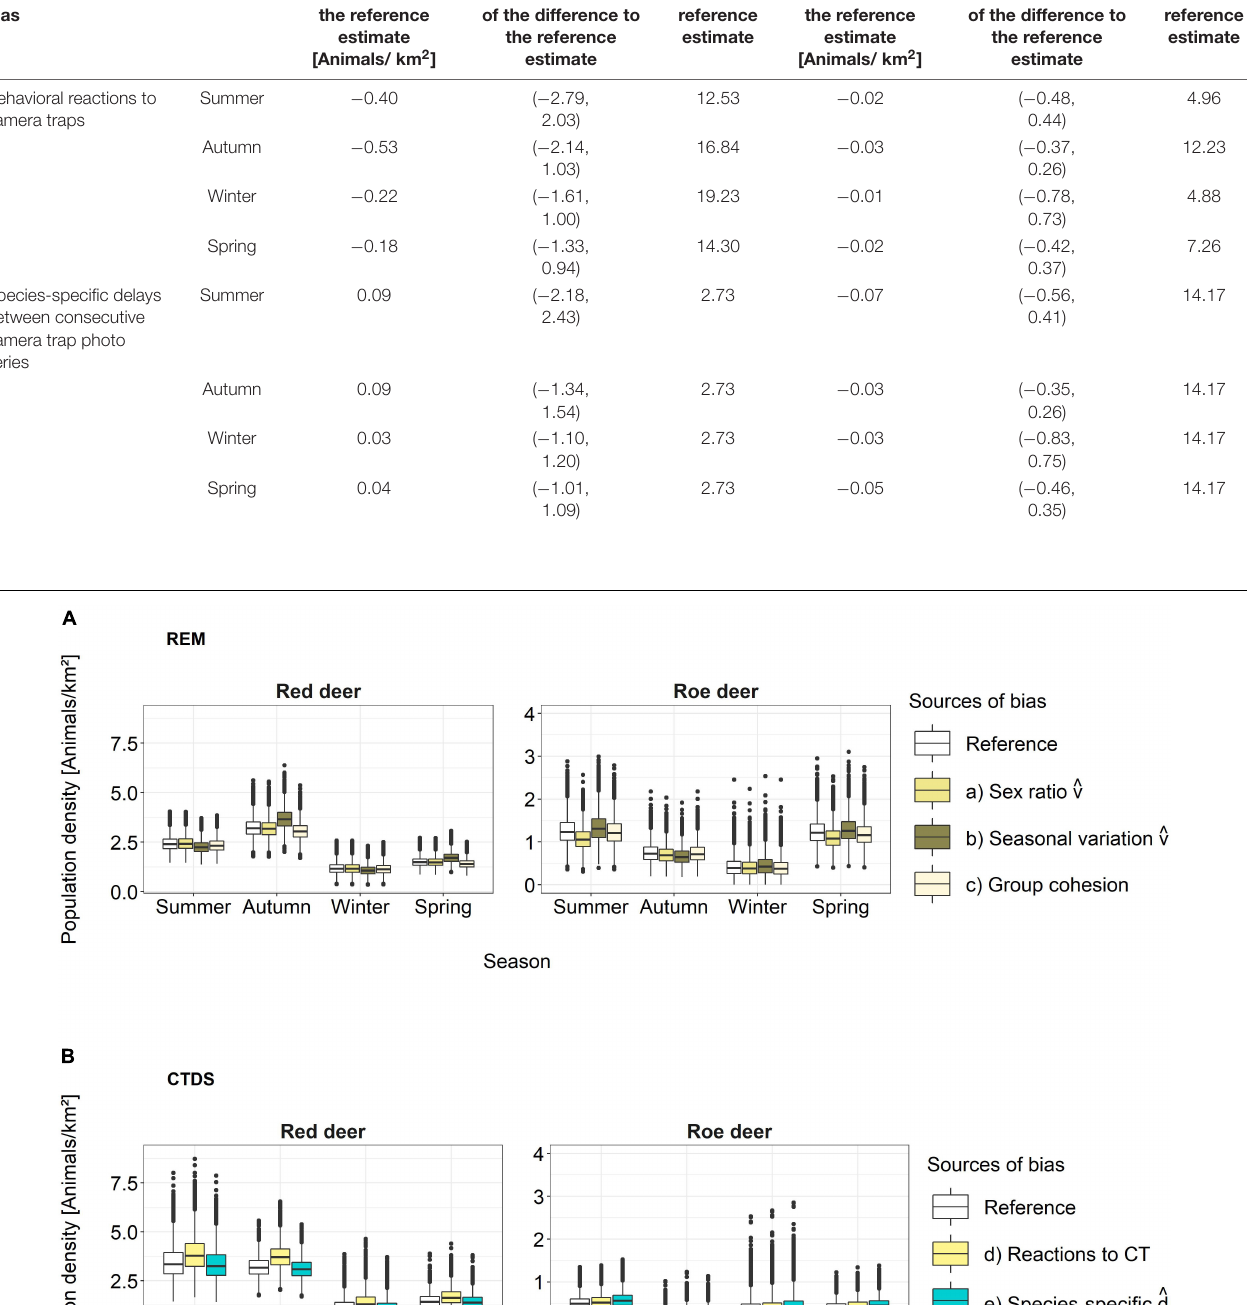
Frontiers in Ecology and Evolution |